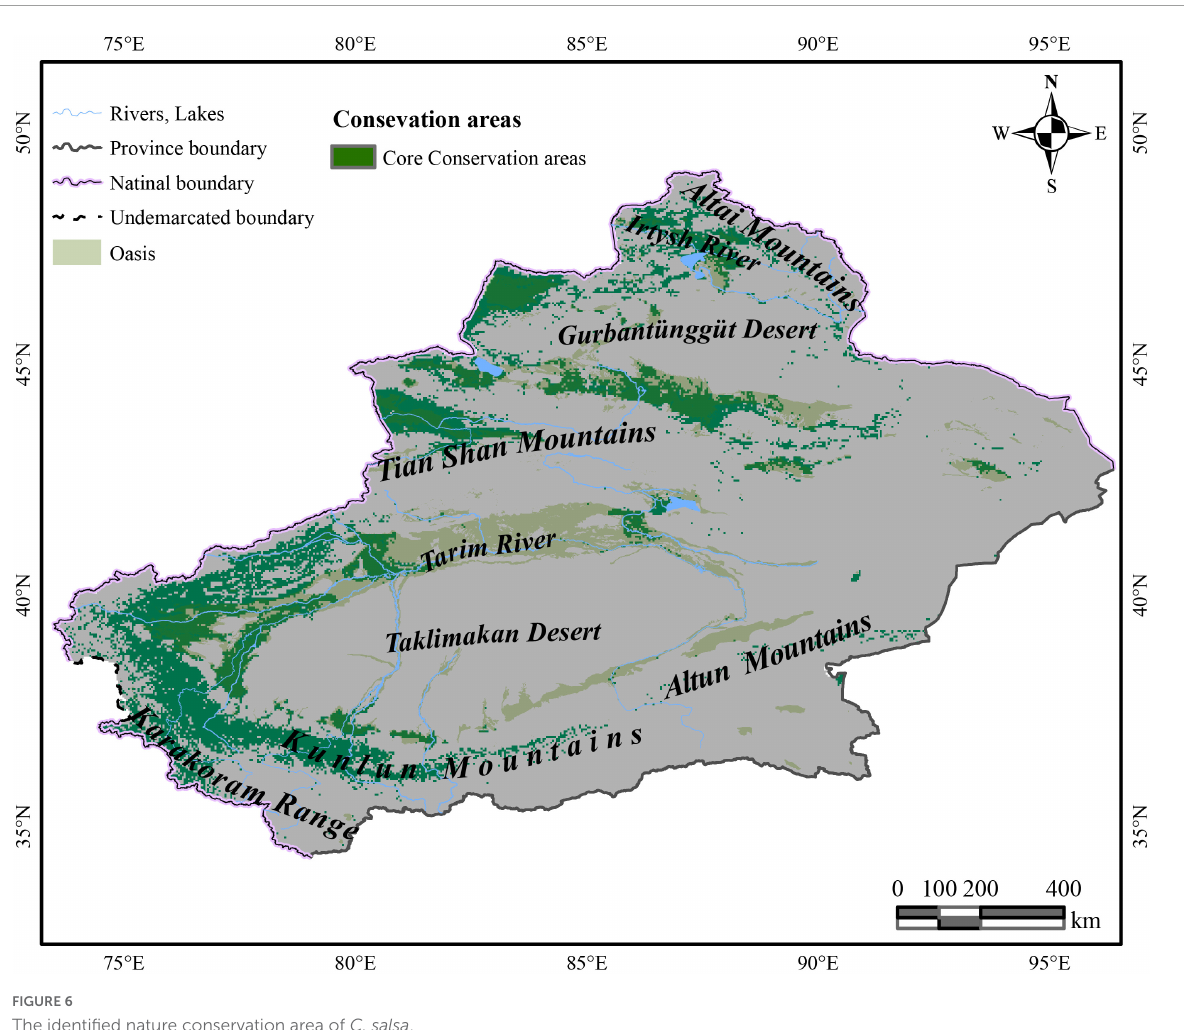
FIGURE6 The identified nature conservation area of C. salsa